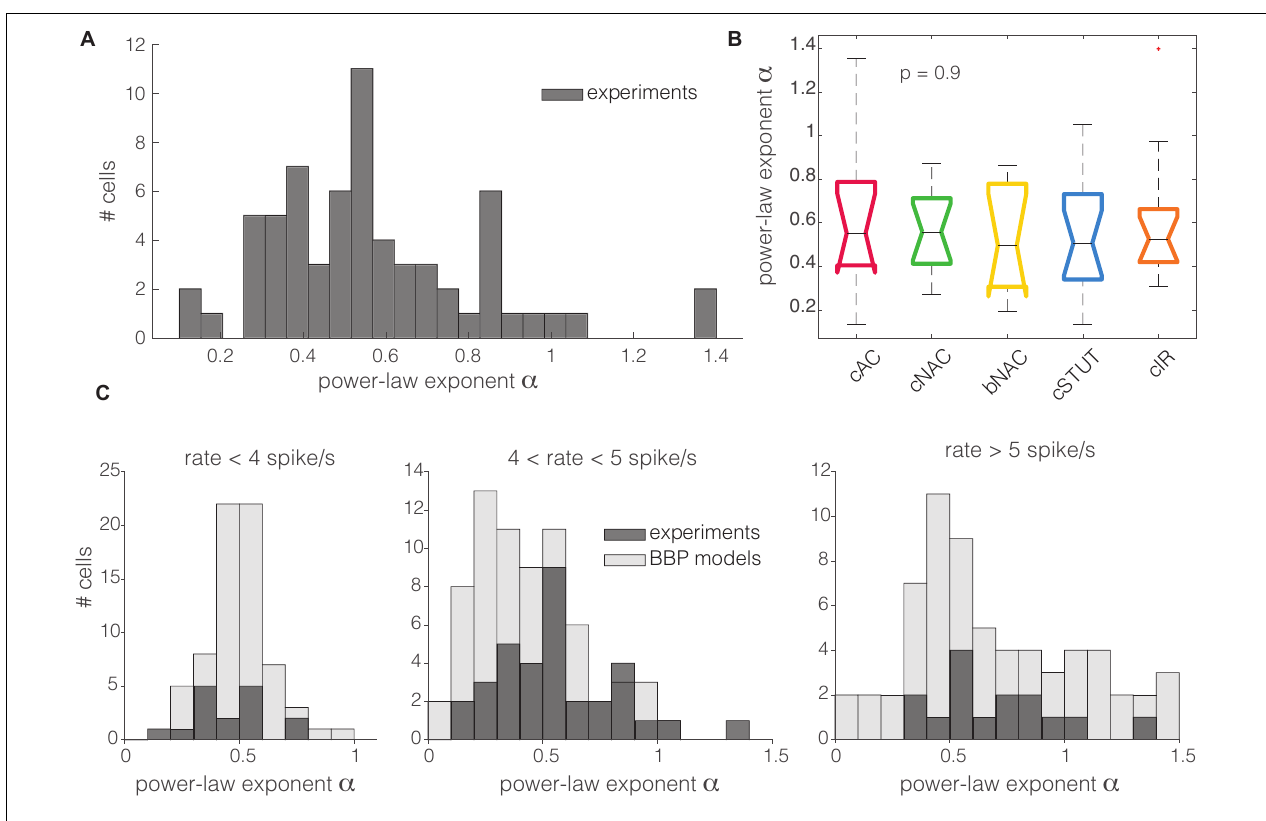
FIGURE 5 | The distribution of the power-law exponent at high spectral frequencies. Almost all the cells recorded in this work had a power-law exponent lower than 1 for high spectral frequencies (A) . Concerning the cell subtypes, the same as for Figure 3B , the Kruskal–Wallis statistical test failed to reject at, 1% significance level, the null hypothesis that the cut off frequencies come from the same distribution (B) . The same trend was quantitatively confirmed in silico for the BBP models (C) . Numerical simulations and experimental data were compared over three distinct ranges of experimental firing rates, where the models were set to fire at precisely 3, 5, and 7 spike/s ( C ; from left to right). The histogram overlay displays the model predictions of the horizontal span of the cut off frequencies over the three distinct firing